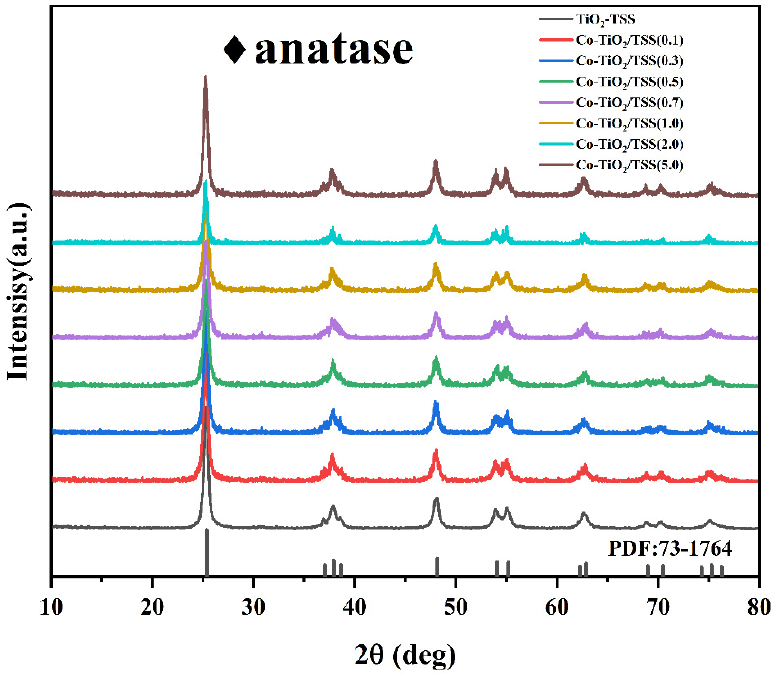
Figure 2. XRD patterns of Co-TiO 2 /TSS(X).